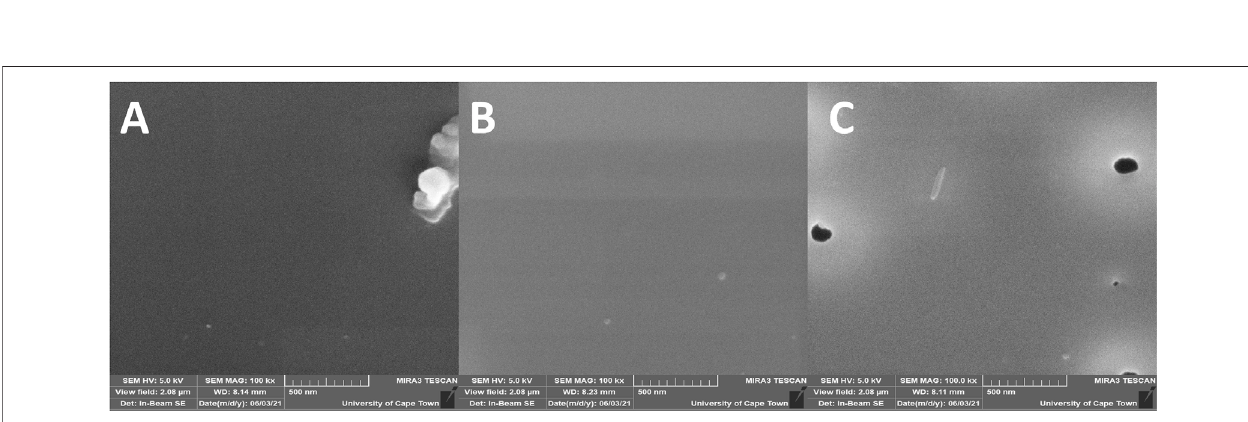
FIGURE 5 | TEM images of HTB-co-P3HT prepared using (A) chlorobenzene, (B) toluene and (C) chloroform as solvents.